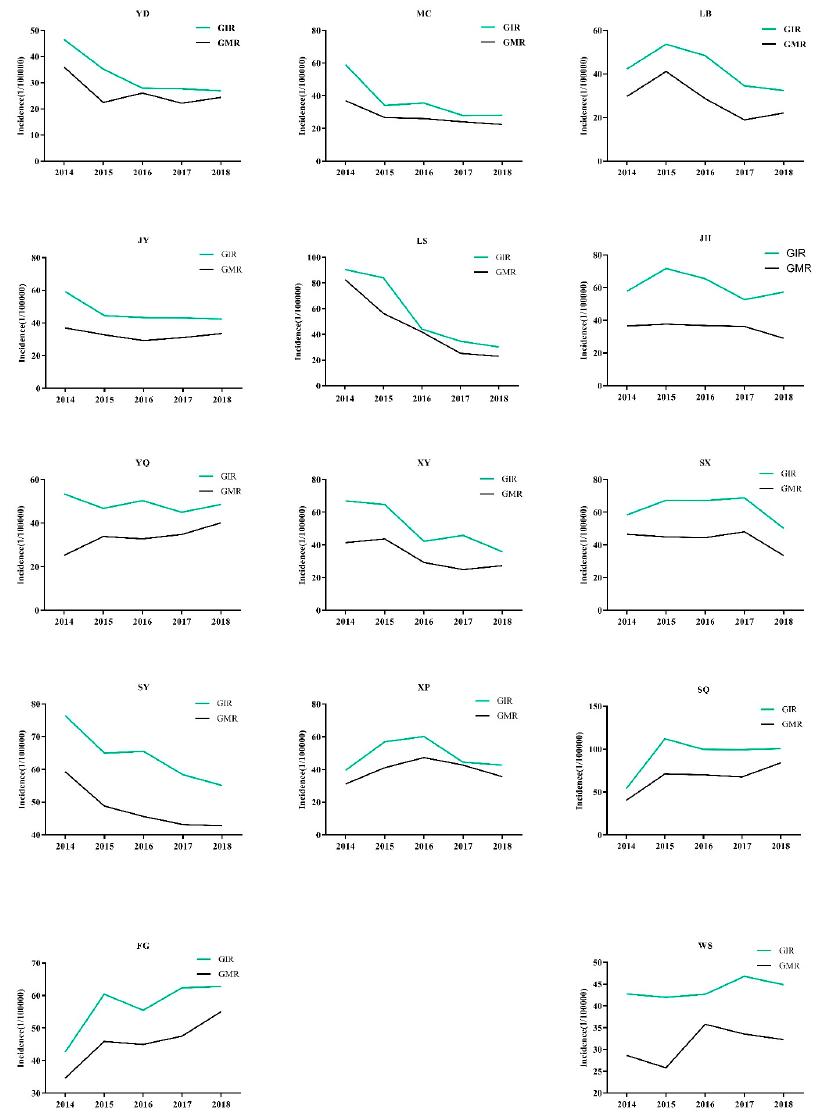
Figure 4. Annual GIR and GMR values from 2014 to 2018 in 14 counties.